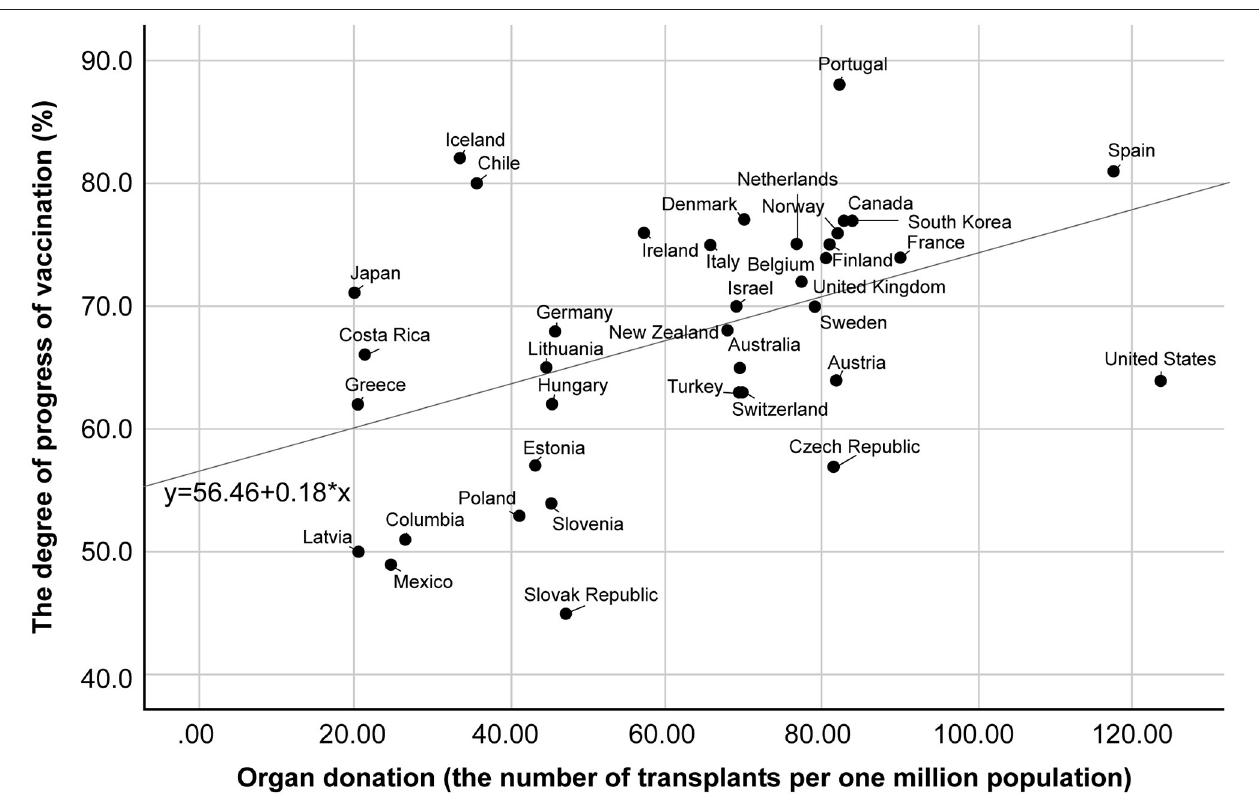
FIGURE 1 | Correlation between COVID-19 vaccination progress and the number of organ donations. COVID-19, coronavirus